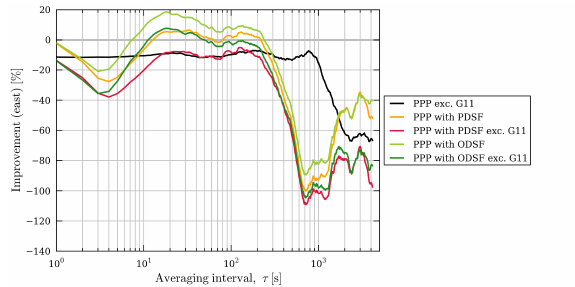
Figure 9: Figure showing the percentage improvement (i.e. reduc- tion) in Allan deviation in easting for station UCL, relative to the Allan deviation values corresponding to standard PPP processing that are shown in Fig.